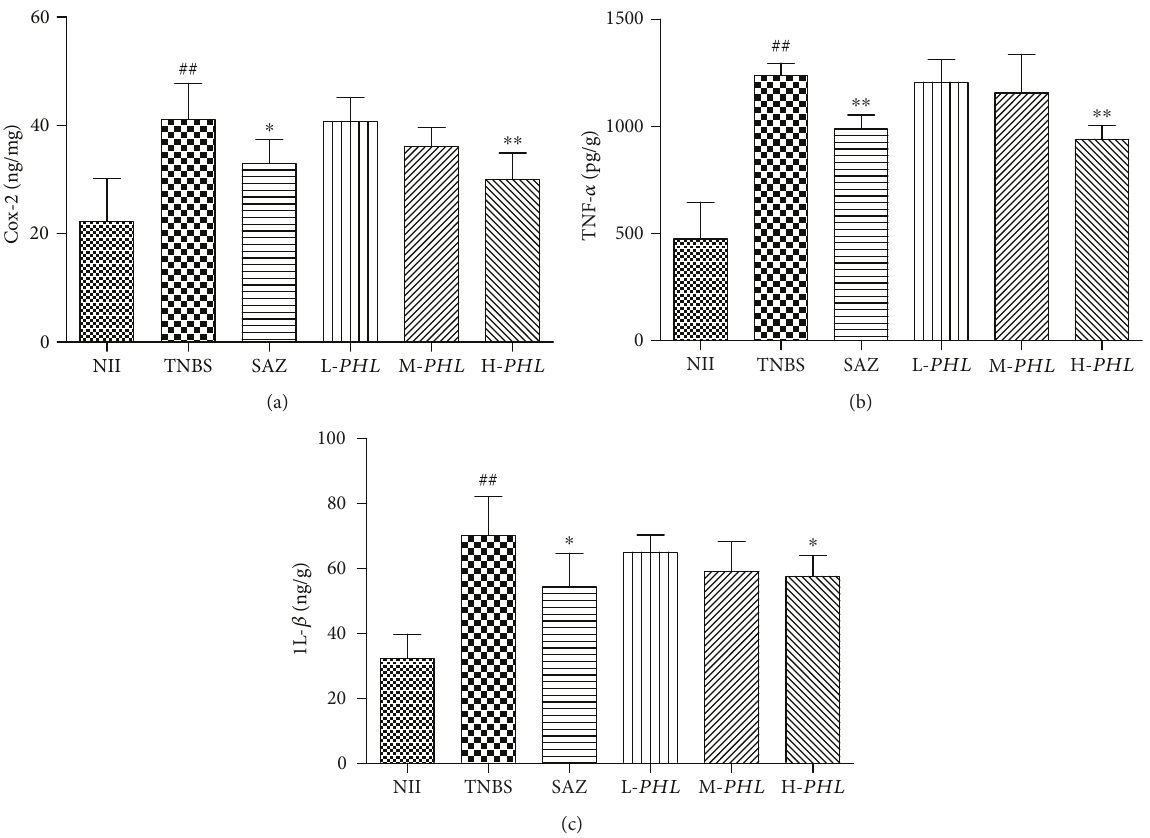
Figure 4: E ff ects of PHL extract (125, 250, and 500mg/kg) and SAZ (120mg/kg) on the colonic production of Cox-2 (a), TNF- α (b), and IL-1 β (c) determined by ELISA. Data are expressed as means ± SD ( n = 8 ); ∗∗ P < 0 01 and ∗ P < 0 05 versus TNBS; ## P < 0 01 versus